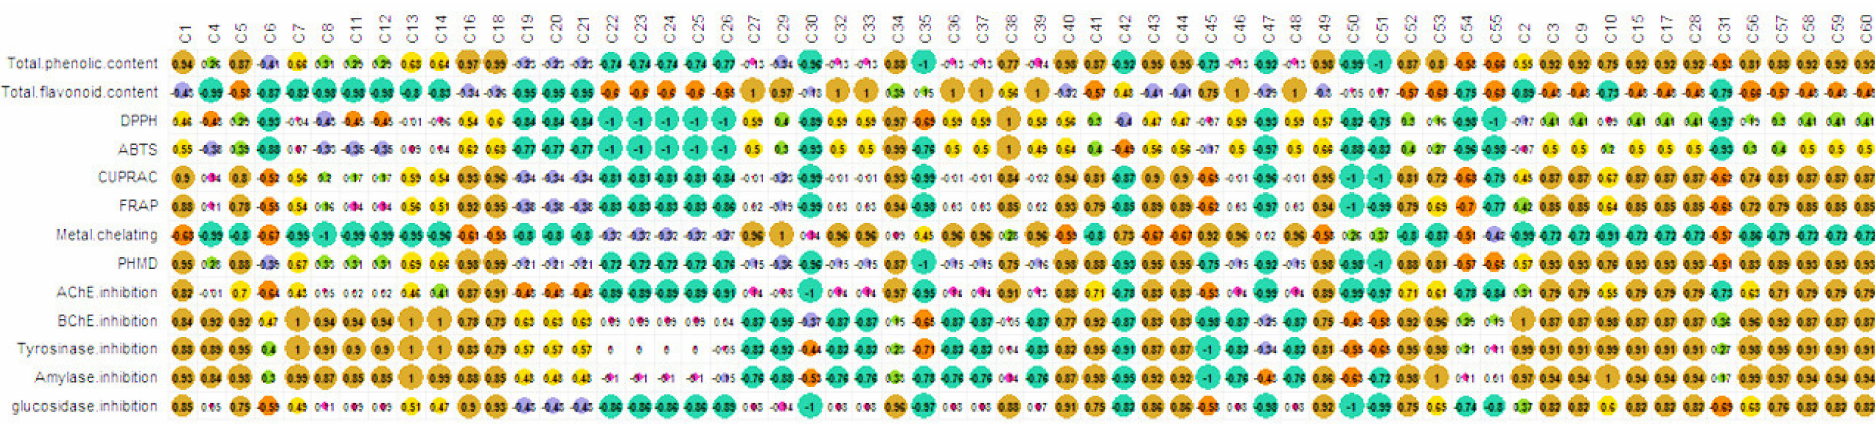
Figure 5. Correlation between evaluated biological activities and identified natural products. Brown color: r = [0.71; 1]; yellow color: r = [0.42; 0.70]; green color: r = [0.16; 0.41]; pink color: r = [ − 0.14; 0.15]; purple color: r = [ − 0.43; − 0.15]; orange color: r = [ − 0.71; − 0.44]; dark green color: r = [ − 1; −